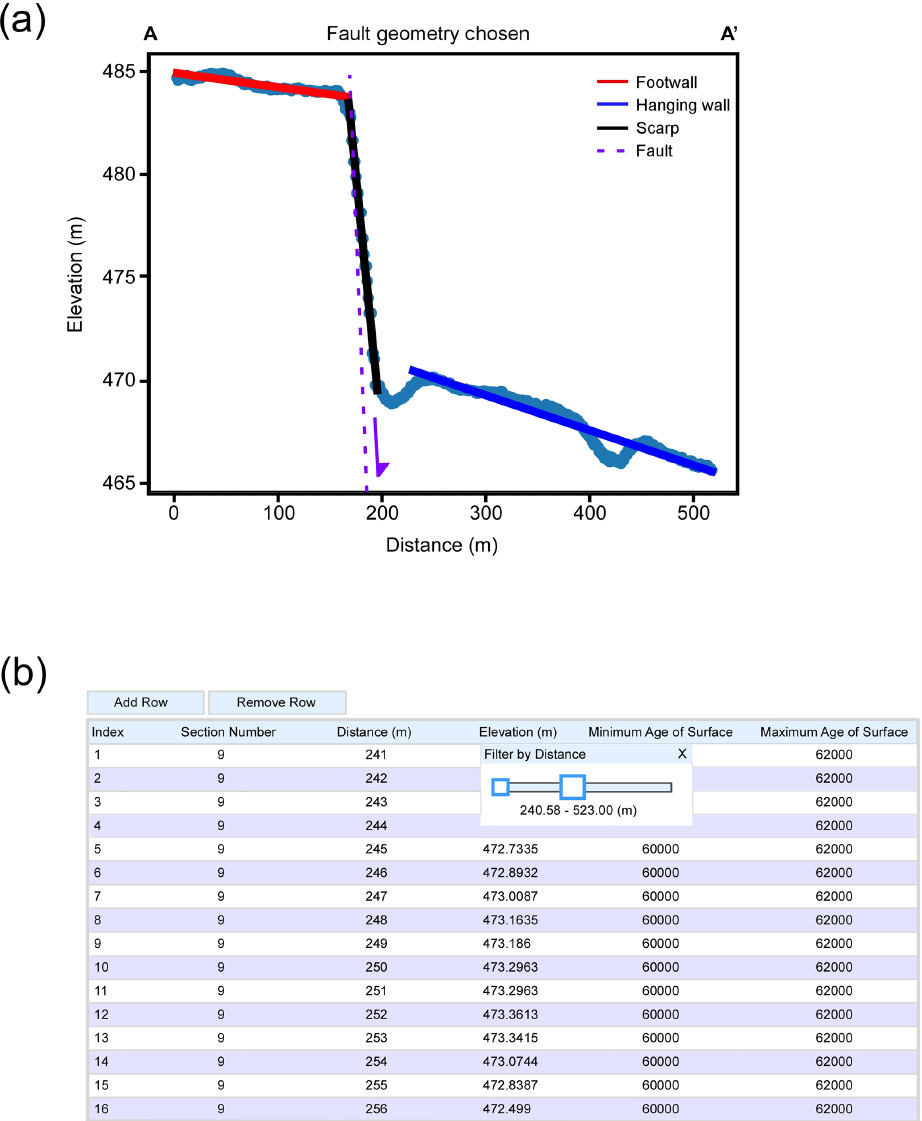
Figure 2. The general workflow. (a) A user-defined profile drawn perpendicular to the strike of a mapped fault. For the location of this feature, see Fig. 4. The red, blue, and black lines represent linear least square fits to the footwall, hanging wall, and scarp of a normal fault, respectively. The purple line is a representation of the geometry of a fault responsible for this scarp. The light blue represents the topographic data. (b) Sliders can be used within the data frame manipulation tool to select data points to represent each relevant component of the fault scarp (e.g., hanging wall, footwall, and scarp). Initially, the red line is fit to all the data in the profile. By using the sliders, you can select a subset of the data as shown in (a) for the generation of the red line. Once data points are selected, the user can visualize the choices for fault component selection before moving forward and calculating slip statistics for the fault in the same Jupyter Notebook environment. The red, blue, and black lines in (a) are generated through this